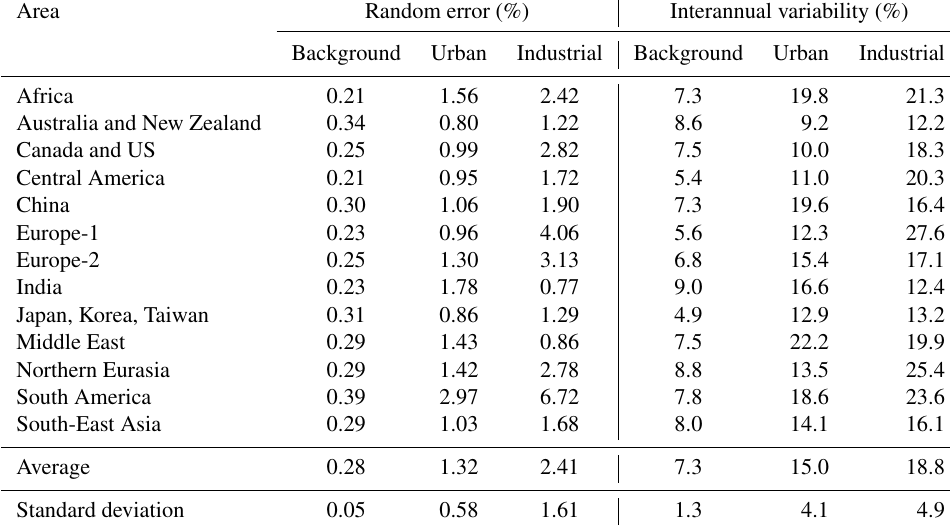
Table 2. The standard deviations of the random errors and interannual variability for background, urban, and industrial components for 13 regions in percent. The random errors and interannual variability are calculated from 3 years (2018, 2019, and 2021) for each area and then averaged for all areas in the region. Interannual variability of the industrial component is calculated for regions with estimated total emissions greater than 1ktyr − 1